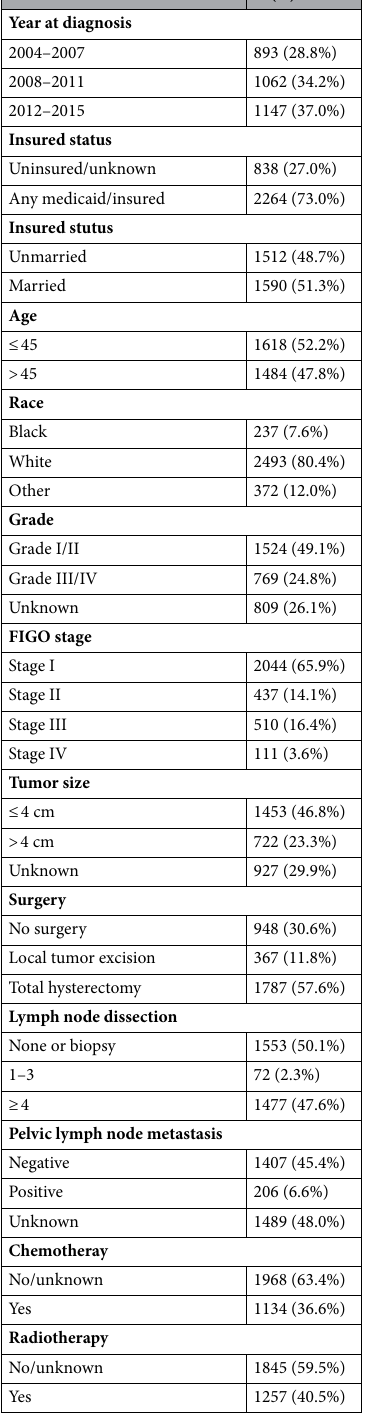
Table 1. The clinicopathological characteristics and treatment of the included 3102 cervical adenocarcinomas